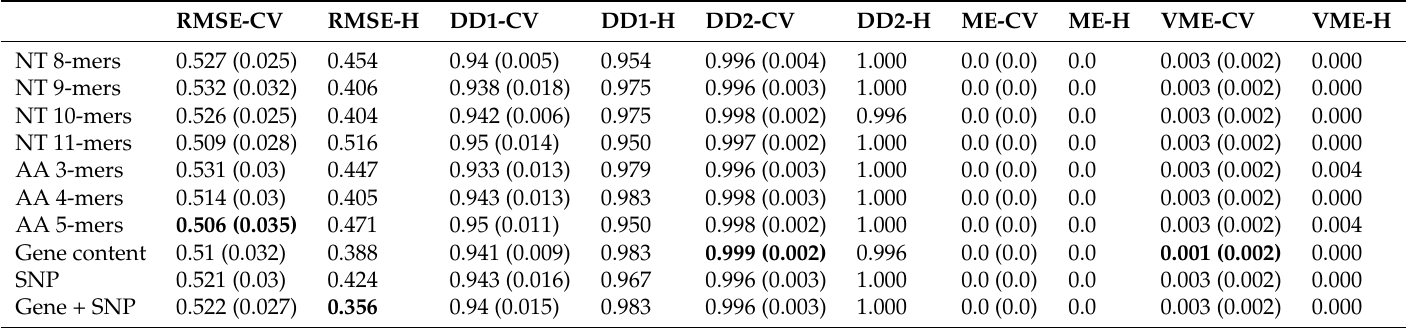
Table A52. S. enterica